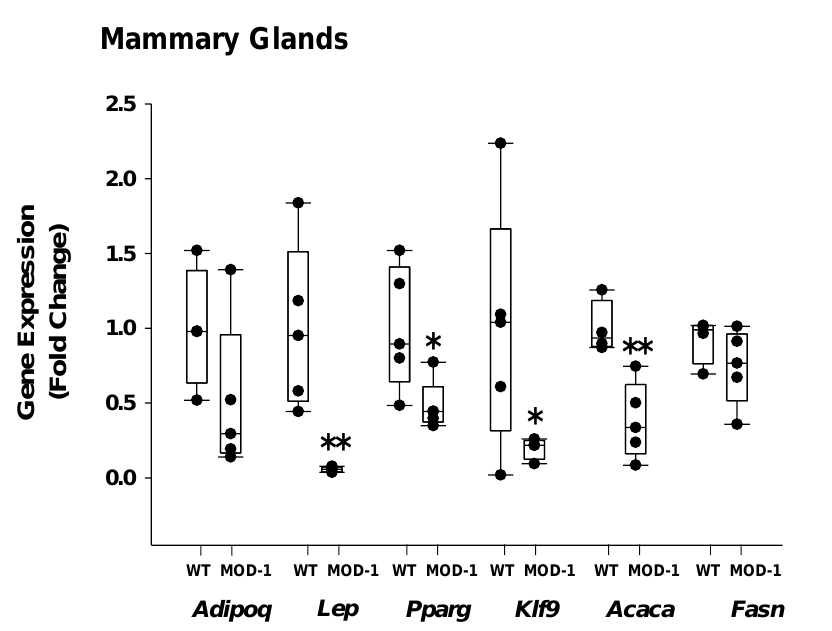
Figure 8. Expression, in mammary gland tissue, of adipogenic/lipogenic genes (female WT and MOD-1 mice who were both fed SPI-HF). qPCR used Actb , Tbp , and Ppia as normalizers, followed by application of geNorm [25]. n = 5 mice/group. * p < 0.05, ** p < 0.01.